Question: Condense the content of this figure into a single sentence.
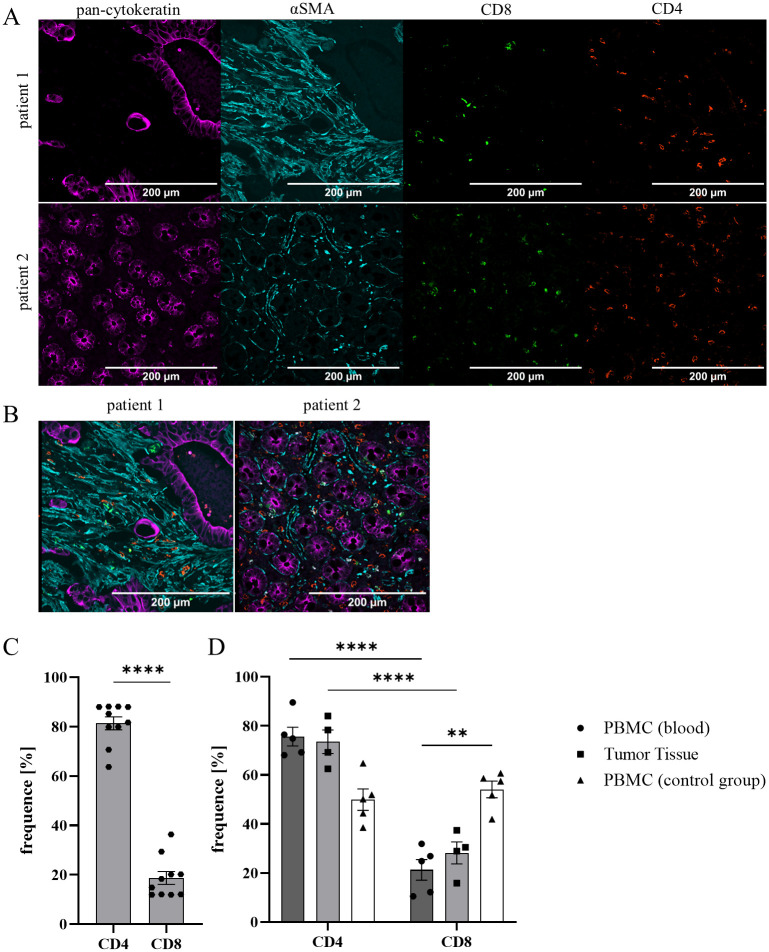
Answer: Intratumoral T-cell distribution and frequency in PDAC patients. Shown are two representative immunofluorescence staining of two tumor slices from PDAC patients with individual channels (A) alongside a merge of all fluorescence channels (B) . Stained are the tumor cell marker pan-cytokeratin (magenta), the fibroblast marker alpha-smooth-muscle-actin (αSMA, cyan), and the T-cell markers CD8 (green) and CD4 (red). Scalebar: 200 µm. (C) Quantification of CD4 + and CD8 + percentages in tumor infiltrating lymphocytes (TIL). Percentages of CD4 + and CD8 + were quantified in tumor slices from 10 PDAC patients conducting image-based analysis. (D) Frequency plot of CD4 and CD8 percentages in PBMC and TIL. Frequency of CD4 + and CD8 + T-cells isolated from the blood of patients or the tumor tissue was analyzed via flow cytometry. PBMC from age-matched healthy donors served as a control group. Error bars indicate the standard errors of the mean of five independent patients, with **p ≤ 0.01, ****p ≤ 0.0001.